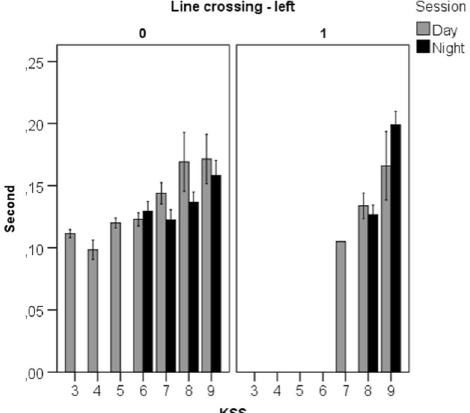
Fig. 5 Line crossings to the left (0 = 0 line crossings; 1= ≥ 1 line crossing), day and night for Karolinska sleepiness Scale in relation to blink duration. Error bars represent Standard error of mean